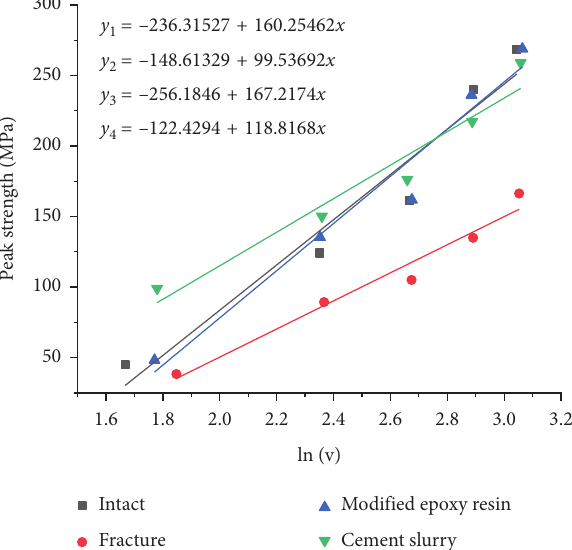
Figure 5: Impact speed and strength. Figure 6: Logarithm of impact speed and peak